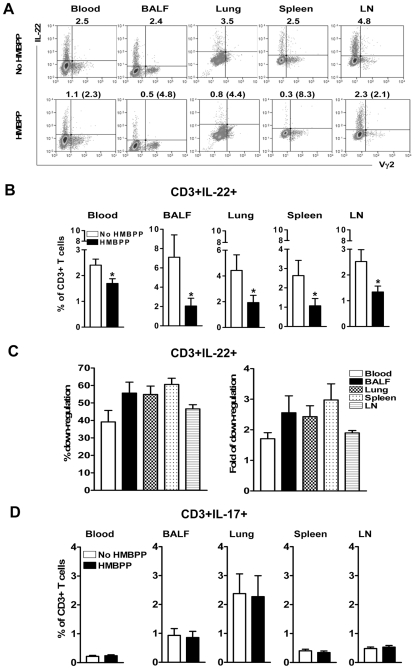
Phosphoantigen HMBPP activation of Vγ2Vδ2 T cells down-regulated the capability of T cells to actively produce IL-22 but not IL-17 de novo in lymphocytes from blood, lungs/BAL fluid, spleens and lymph nodes.Cells from different compartments were either un-stimulated (CD28/CD49d) or stimulated with HMBPP (HMBPP plus CD28/CD49d), and then subjected to intracellular cytokine staining. Blood and BALF were taken at the endpoint matching necropsy schedule after M. tuberculosis infection. (A) Shown on the top panel are representative flow-cytometry histograms of intracellular cytokine staining analysis. The percentage numbers of IL-22-producing T cells in lymphocytes are marked above individual histograms. The bottom-panel flow-cytometry histograms show that HMBPP activation resulted in a reduction in numbers of T cells capable of producing IL-22. The numbers in parentheses denote folds of reduction (ratio of numbers of IL-22-producing T cells from unstimulated versus HMBPP stimulated measurements) after HMBPP treatment. Data were gated on CD3. The flow histograms were from representative M. tuberculosis-infected macaque CN7234 (blood), CN7222 (BAL fluid), RH7716 (lung), RH7717 (spleen) and RH7720 (mesenteric LN) respectively. CN (cynomolgus macaque). (B) Comparative analyses of IL-22-producing T cells in the presence and absence of HMBPP stimulation. Data are mean percentage numbers ± SEM derived from macaque animals' blood (n = 7, cynomolgus), BAL fluids (n = 5, cynomolgus), lungs (n = 7, rhesus), spleens (n = 11, rhesus) and mesenteric lymph nodes (n = 8, rhesus). *, P<0.05, **, P<0.01. Data were gated on CD3. (C) Bar graphic data show percentages (left) and folds (right) of down-regulation of IL-22-producing T cells after HMBPP stimulation. The fold of down-regulation was defined the same as above in Fig. 3A. The percentages of down-regulation were calculated by the formula [(Unstimulated–HMBPP-stimulated)/Unstimulated × 100%]. Results were shown as mean ± SEM. Data were gated on CD3. (D) Comparative analyses of IL-17-producing T cells in the presence and absence of HMBPP stimulation. Data are mean percentage numbers ± SEM derived from macaque animals' blood (n = 9, cynomolgus), BAL fluids (n = 9, cynomolgus), lungs (n = 15, rhesus), spleens (n = 16, rhesus) and mesenteric lymph nodes (n = 20, rhesus). Data were gated on CD3.